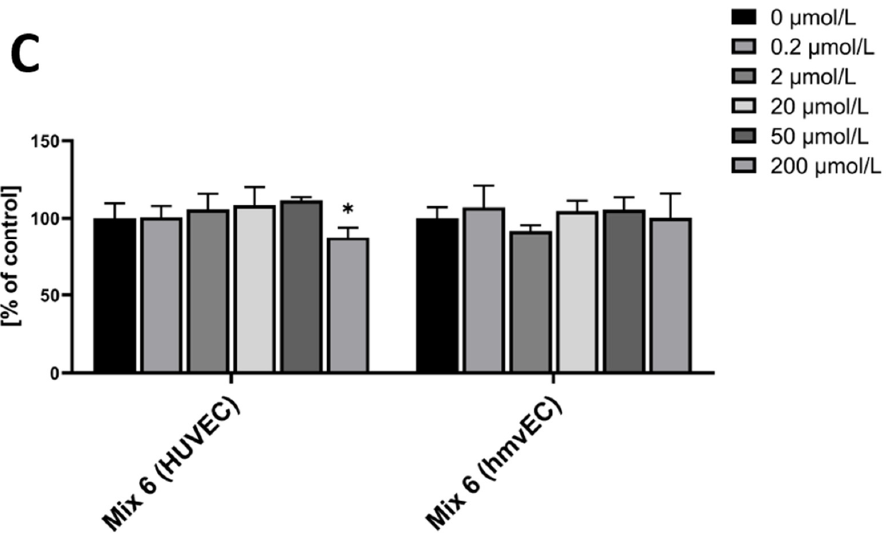
Figure 4. DCF-DA fluorescence relative to control in HUVEC ( A ) and hmvEC ( B ) with the respective cumulative concentration and respective anthocyanin or metabolite ( C ) combinations; results are expressed as mean ± SD; * p < 0.05 compared to 0 µ g/mL of the respective mix; n = 4 technical